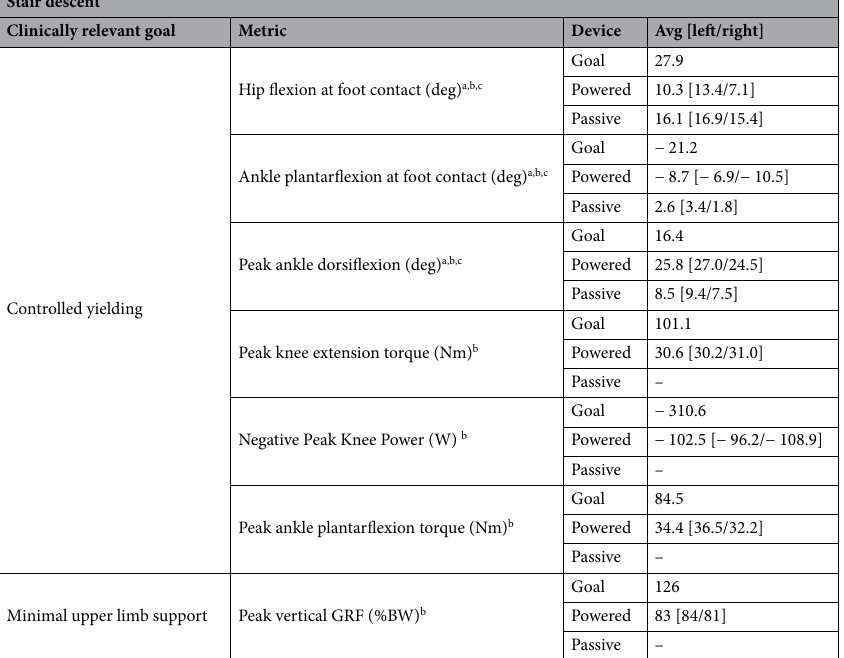
Table 3. Clinically relevant goals and metrics during stair descent for the powered and passive prostheses. a Statistically significant difference between powered and passive prostheses. b Statistically significant difference between powered prostheses and nonamputee reference. c Statistically significant difference between passive prostheses and nonamputee